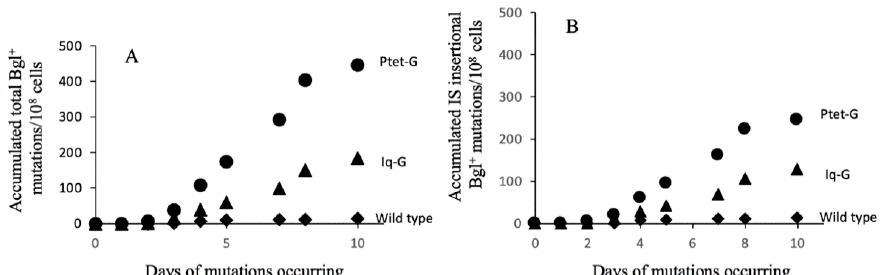
Figure 1. Effects of different levels of constitutively expressed bglG on Bgl + mutations on minimal M9 + salicin agar plates. A total of 2 × 10 7 cells were applied onto each minimal M9 agar plate containing 0.5% salicin as the sole carbon source. The plates were incubated at 30 °C, being examined daily for the appearance of Bgl + colonies. The total Bgl − cell populations were determined as reported previously [8,31]. The frequencies of Bgl + mutations were determined by dividing the number of Bgl + colonies by the total Bgl − populations. ( A ) Accumulated total Bgl + mutations in cells constitutively expressing bglG . A new copy of bglG , driven by the strong constitutive promoter P tet (strain Ptet-G) or the weaker promoter lacIq (strain Iq-G), was located at the intS locus on the chromosome. Total Bgl + mutations include IS insertional mutations and non-IS insertional mutations. ( B ) Accumulated IS insertional Bgl + mutations in cells constitutively expressing bglG . At least 100 independent Bgl + mutants for each test strain were used to determine the ratio of IS insertional mutants versus non- insertional mutants. Note: The x -axis shows the day that mutations occurred, not when mutant colonies become visible. The same use of this x -axis occurs in Figures 1–6 where applicable (see Materials and